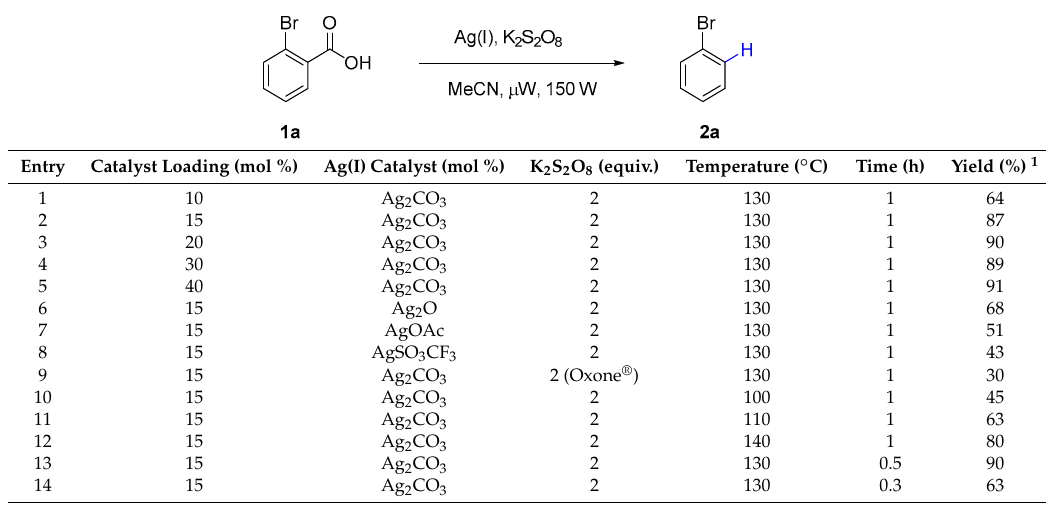
Table 1. Selected results for the optimization of protodecarboxylation reaction conditions.